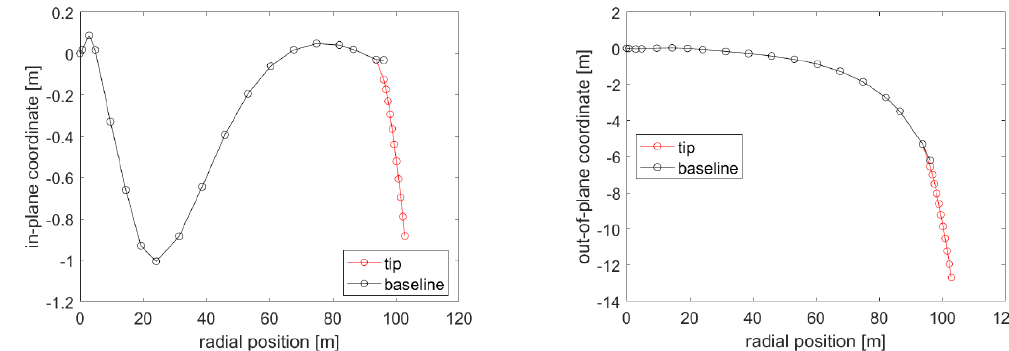
Figure 9. Blade centerline of the optimized design.